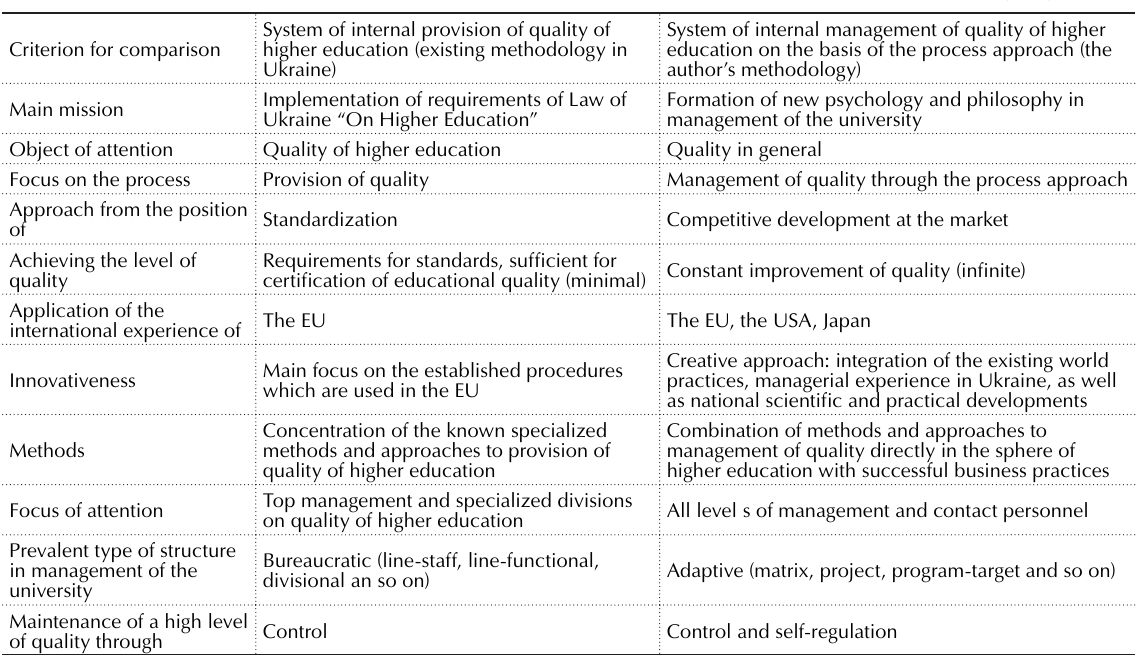
Table 1. Distinctive features of the author’s concept and methodology of internal management of quality of higher education on the basis of the process